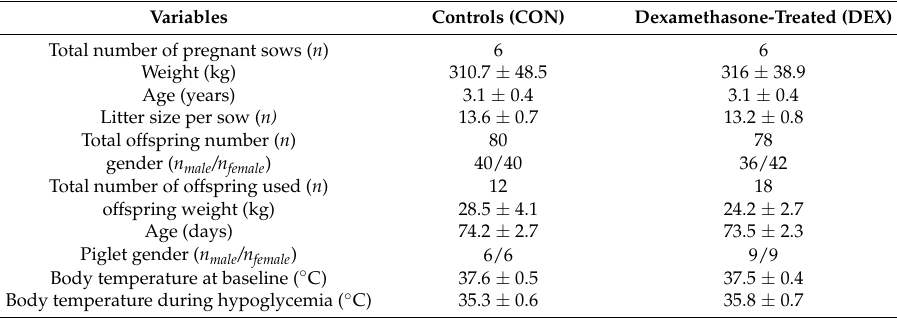
Table 2. Breeding data and experimental